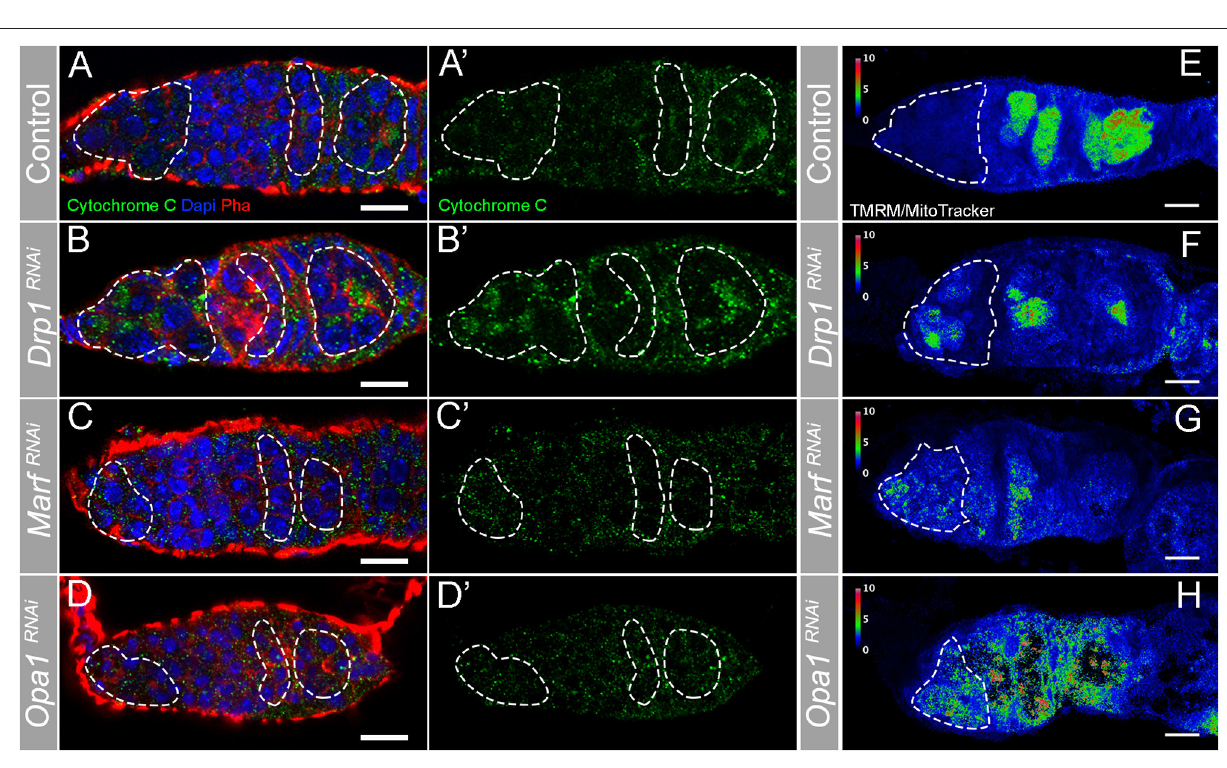
FIGURE 3 | RNAi of Drp1 , Marf , or Opa1 disrupts mitochondria morphology in the germarium increasing mitochondrial membrane potential in GSCs. (A–H) Representative images of germaria expressing mCherry RNAi , Drp1 RNAi , Marf RNAi , and Opa1 RNAi driven by nos Gal4. (A–D) Mitochondria are labeled by Cytochrome c antibody (green). Outlines are indicative of the areas where GSCs (in region 1) and their lineage (in regions 2b and 3) are found to facilitate visual comparison. (A,A ′ ) In control germaria, fissed mitochondria are visible in GSCs (region 1), whereas differentiating cysts (regions 2b − 3) have progressively more aggregated mitochondria suggesting a higher fusion-to-fission ratio. (B,B ′ ) Drp1 RNAi causes hyperfusion of mitochondria in both GSCs (region 1) and differentiating cysts (regions 2b − 3). (C,C ′ ,D,D ′ ) RNAi of Marf or Opa1 in germ cells leads to a decrease of fused/aggregated mitochondria in regions 2b − 3. Nuclei and F-actin are labeled with DAPI (blue) and Phalloidin (Pha, red), respectively. (E–H) Ratiometric images of germaria stained with TMRM (indicator of mitochondrial membrane potential) and MitoTracker (indicator of mitochondrial mass). The ratio of TMRM to MitoTracker intensity was calculated in Fiji, and a pseudo-colored image was generated using the rainbow RGB gradient. Outlines indicate region 1, where GSCs are localized. (E) Control GSCs have small TMRM/MitoTracker values, indicating low mitochondrial membrane potential. GSCs expressing Drp1 RNAi (F) , Marf RNAi (G) , or Opa1 RNAi (H) have higher TMRM/MitoTracker ratios than control, indicating that depletion of fission or fusion increases mitochondrial membrane potential. Scale bars represent 10 µ m.